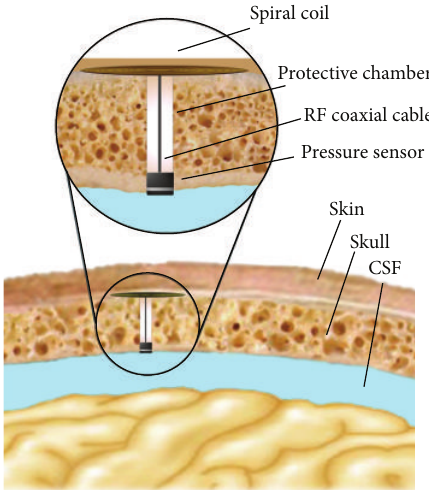
Figure 1: Conceptual illustration of the implant